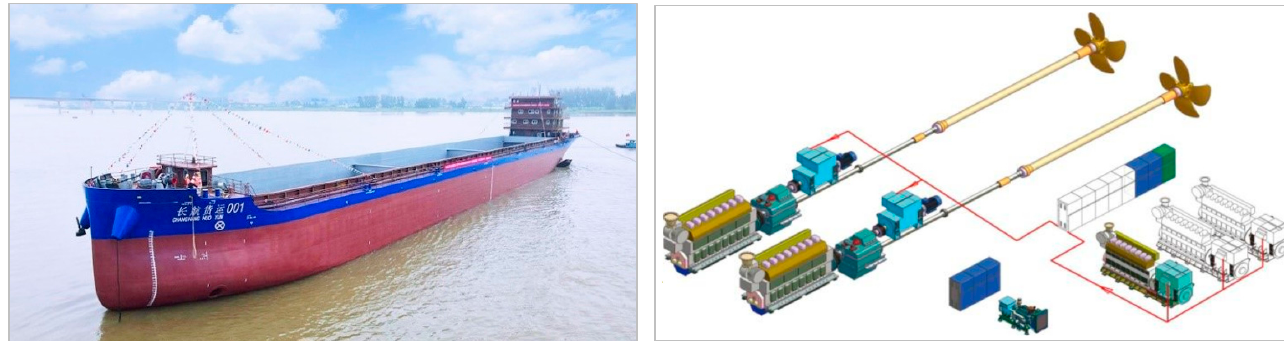
Figure 7. Hybrid-powered bulk carrier Changhang Cargo 001.